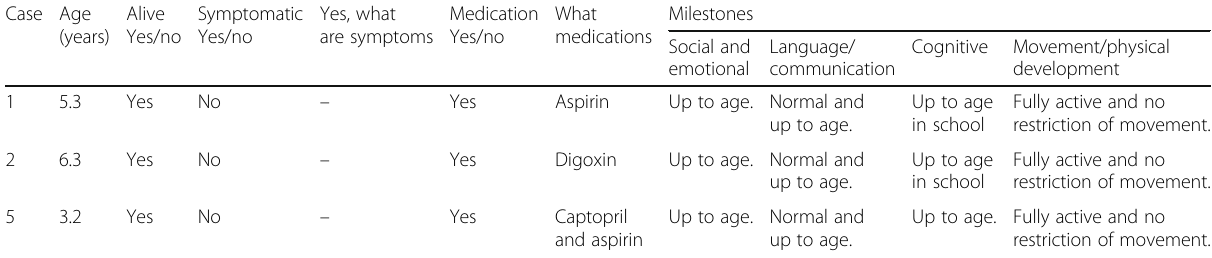
Table 4 Quality of life assessment Case Age Alive Symptomatic (years) Yes/no